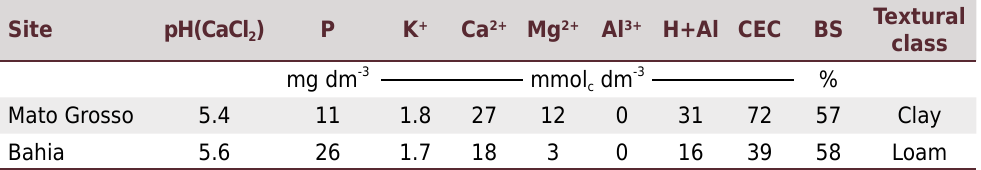
Table 1. Chemical characterization of soil from the two experimental sites, obtained from a depth of 0.00-0.20 m Site pH(CaCl 2